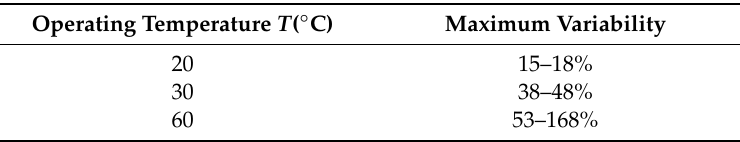
Table 4. Maximum Variability in strain.